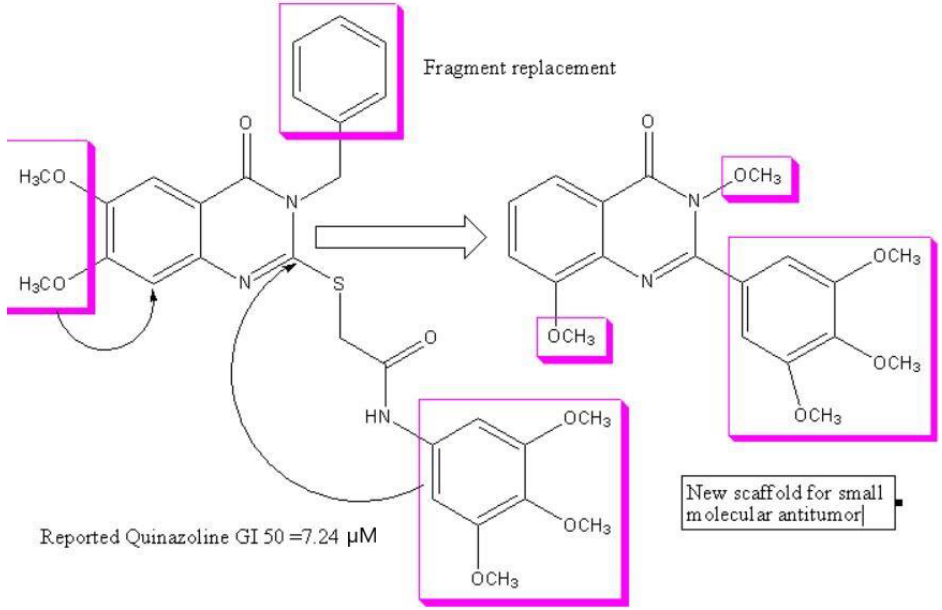
Figure 2. Reported quinazoline with GI 50 µg/mL [15] and designed quinazoline derivatives as antitumor compounds.